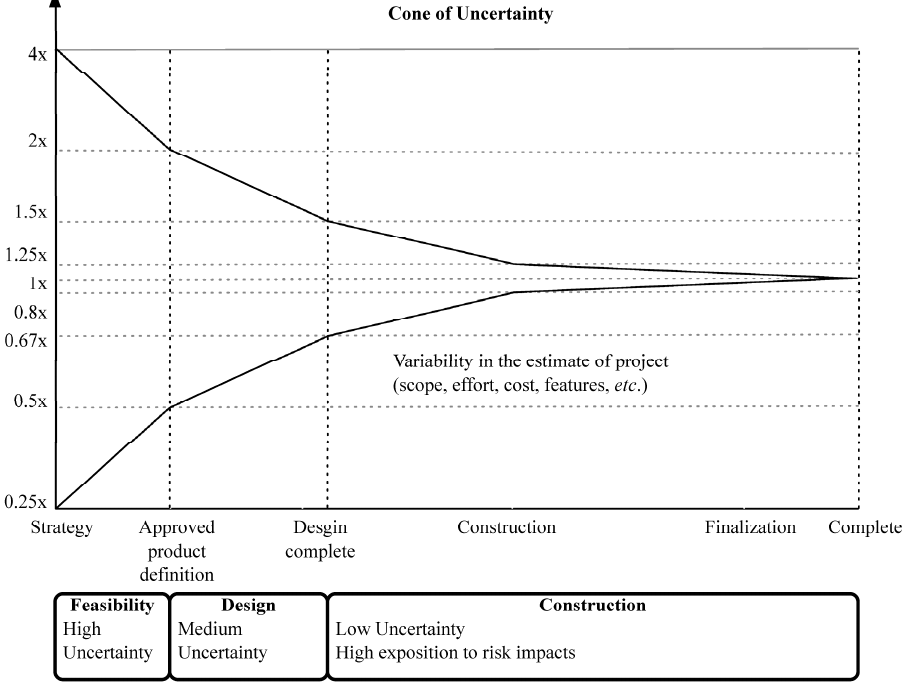
Figure 2. The cone of uncertainty for sequential project development (adapted from McConnell